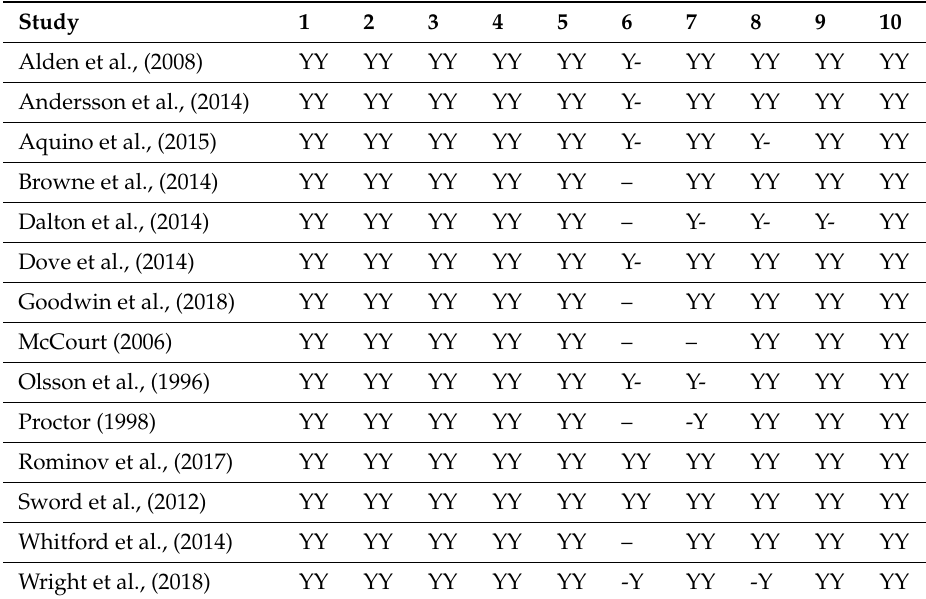
Table 2. Quality assessment of included